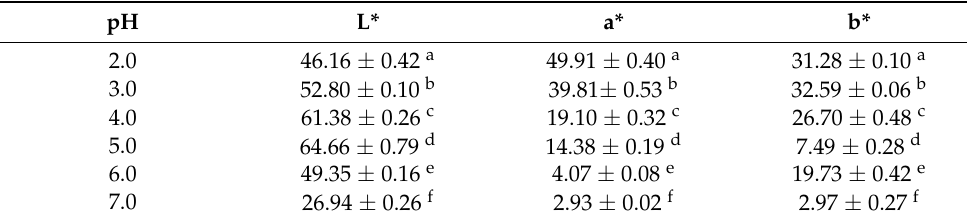
Table 1. Total color change values for the AE.